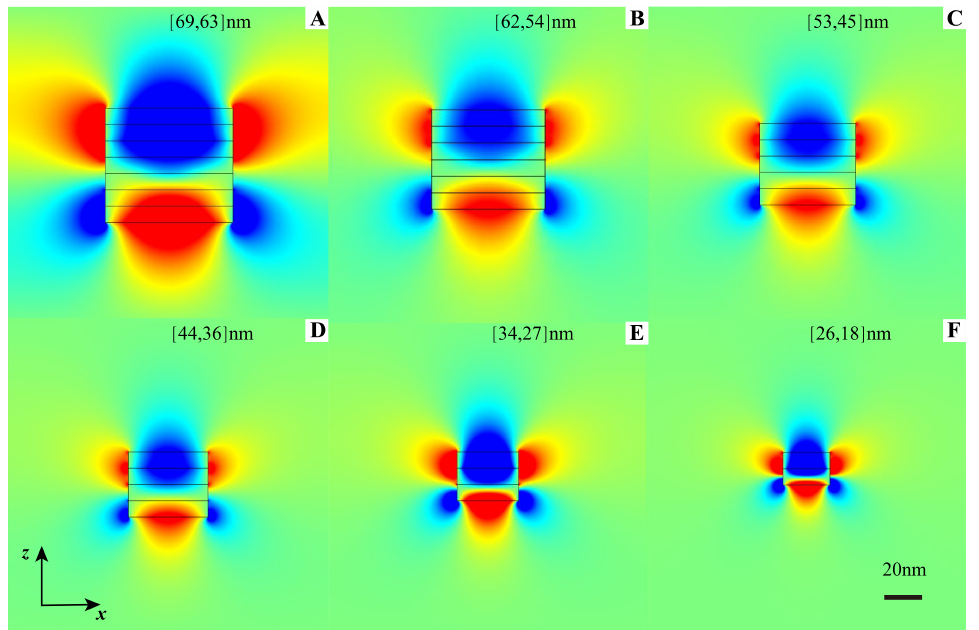
Figure 3. Mode distribution profiles with different cavity sizes. Electric field E x of the (1, 1) mode for graphene indefinite nanoscale cavities with different (width, height) sizes but at the same resonant frequency